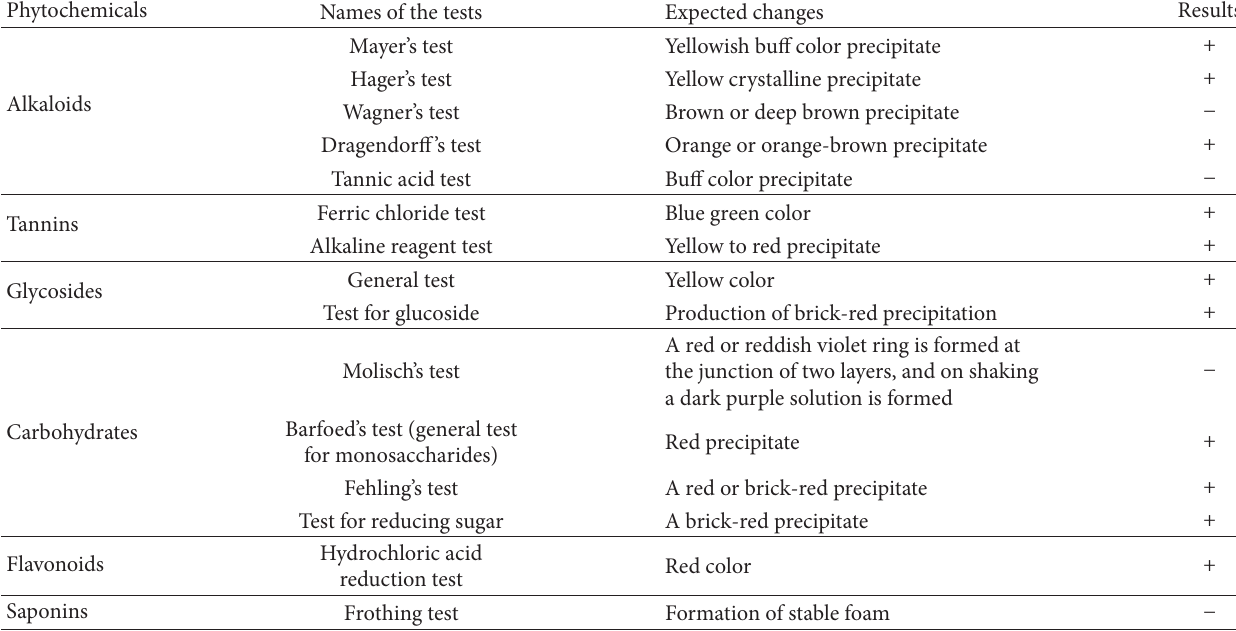
Table 1: Phytochemicals identified in